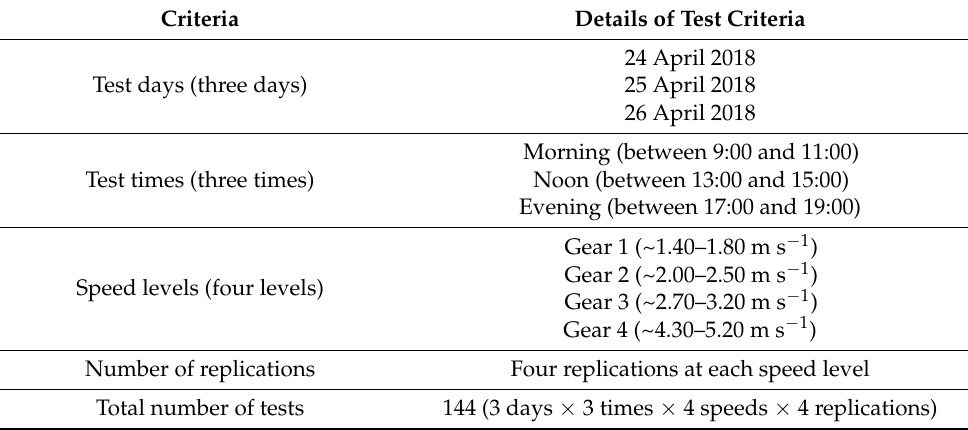
Table 2. Some details of the speed measurement